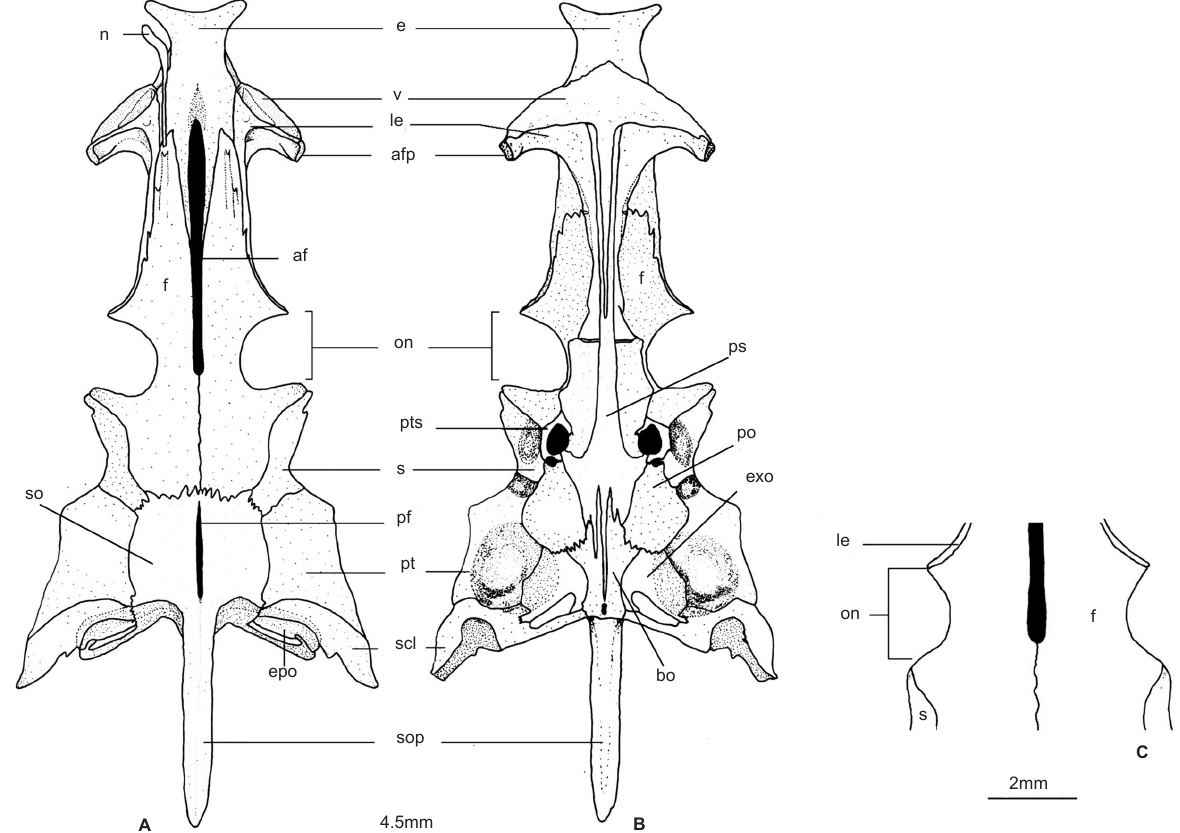
Figure 5. Views of skull: A - dorsal, B - ventral of G. chindwinica (MUMF- 9997); C - part of dorsal of G. ngapang (MUMF- 6141). Af - anterior cranial fontanelle; afp - articular facet for palatine; bo - bassioccipital; e - mesethmoid; epo - epeotic; exo - exoccipital; f - frontal; le - lateral ethmoid; n - nasal; on - orbital notch; pf - posterior cranial fontanelle; po - prootic; pt - pterotic; pts - pterosphenoid; scl - supracleithrum; so - supraoccipital; s - sphenotic; v - vomer.